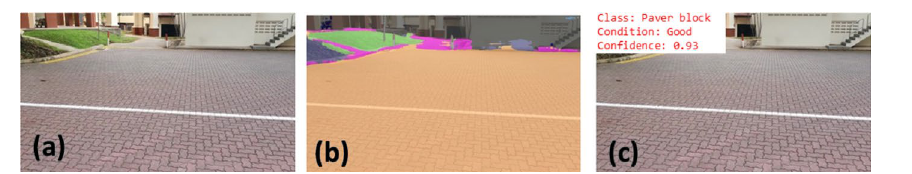
Figure 28. Pavement condition: good.